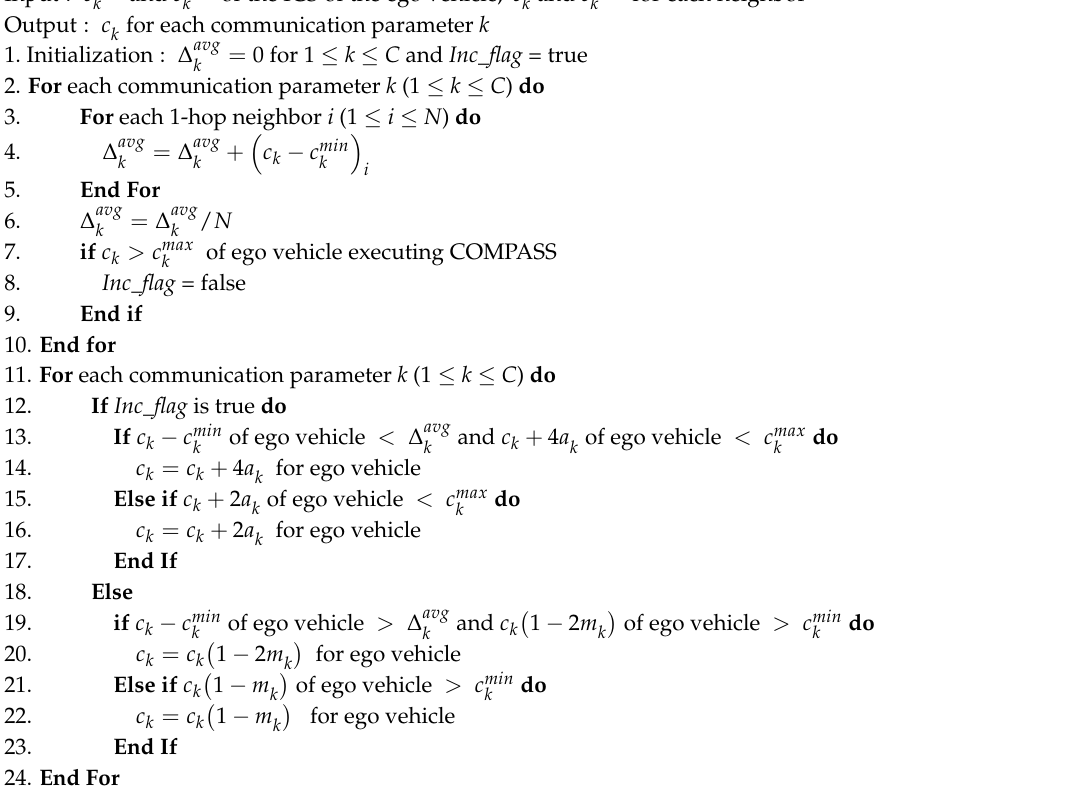
Algorithm 2. Update communication parameters of the ego vehicle executing